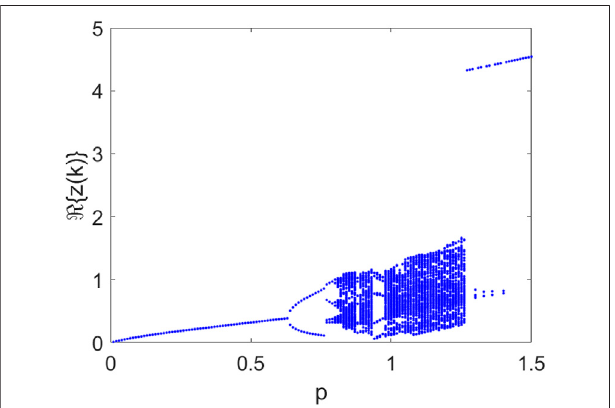
FIGURE 1 | Bifurcation diagram of the logistic map in Eq. 2 with respect to a .